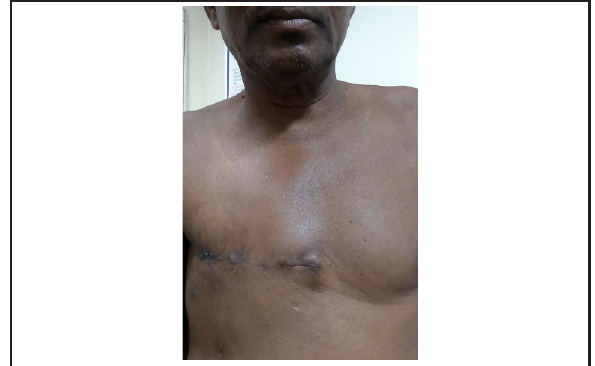
Figure 2. Post-operative picture of the right breast carcinoma on follow up